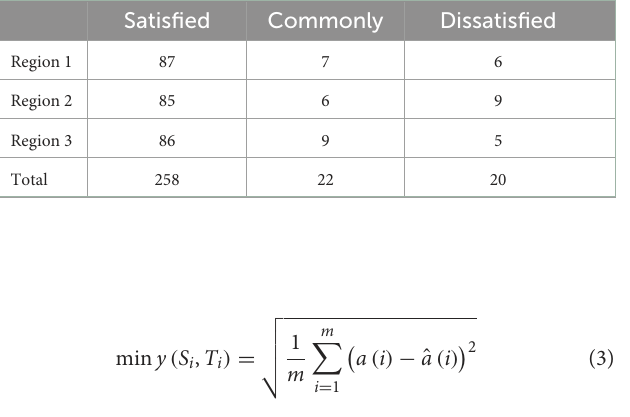
TABLE 1 Satisfaction of civil servants in three regions with psychological intervention